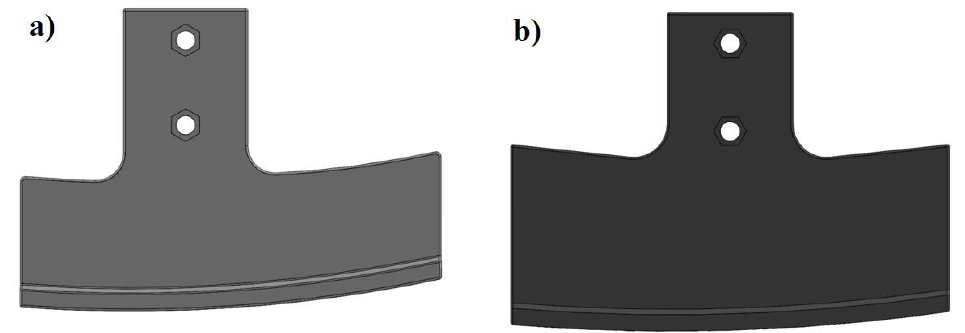
ff erent blades’ shape: ( a ) L shape, ( b ) T Figure 10. Analysis of different blades’ shape: ( a ) L shape, ( b ) T shape. Figure 10. Analysis of di Figure 10. Analysis of different blades’ shape: ( a ) L shape, ( b ) T shape.